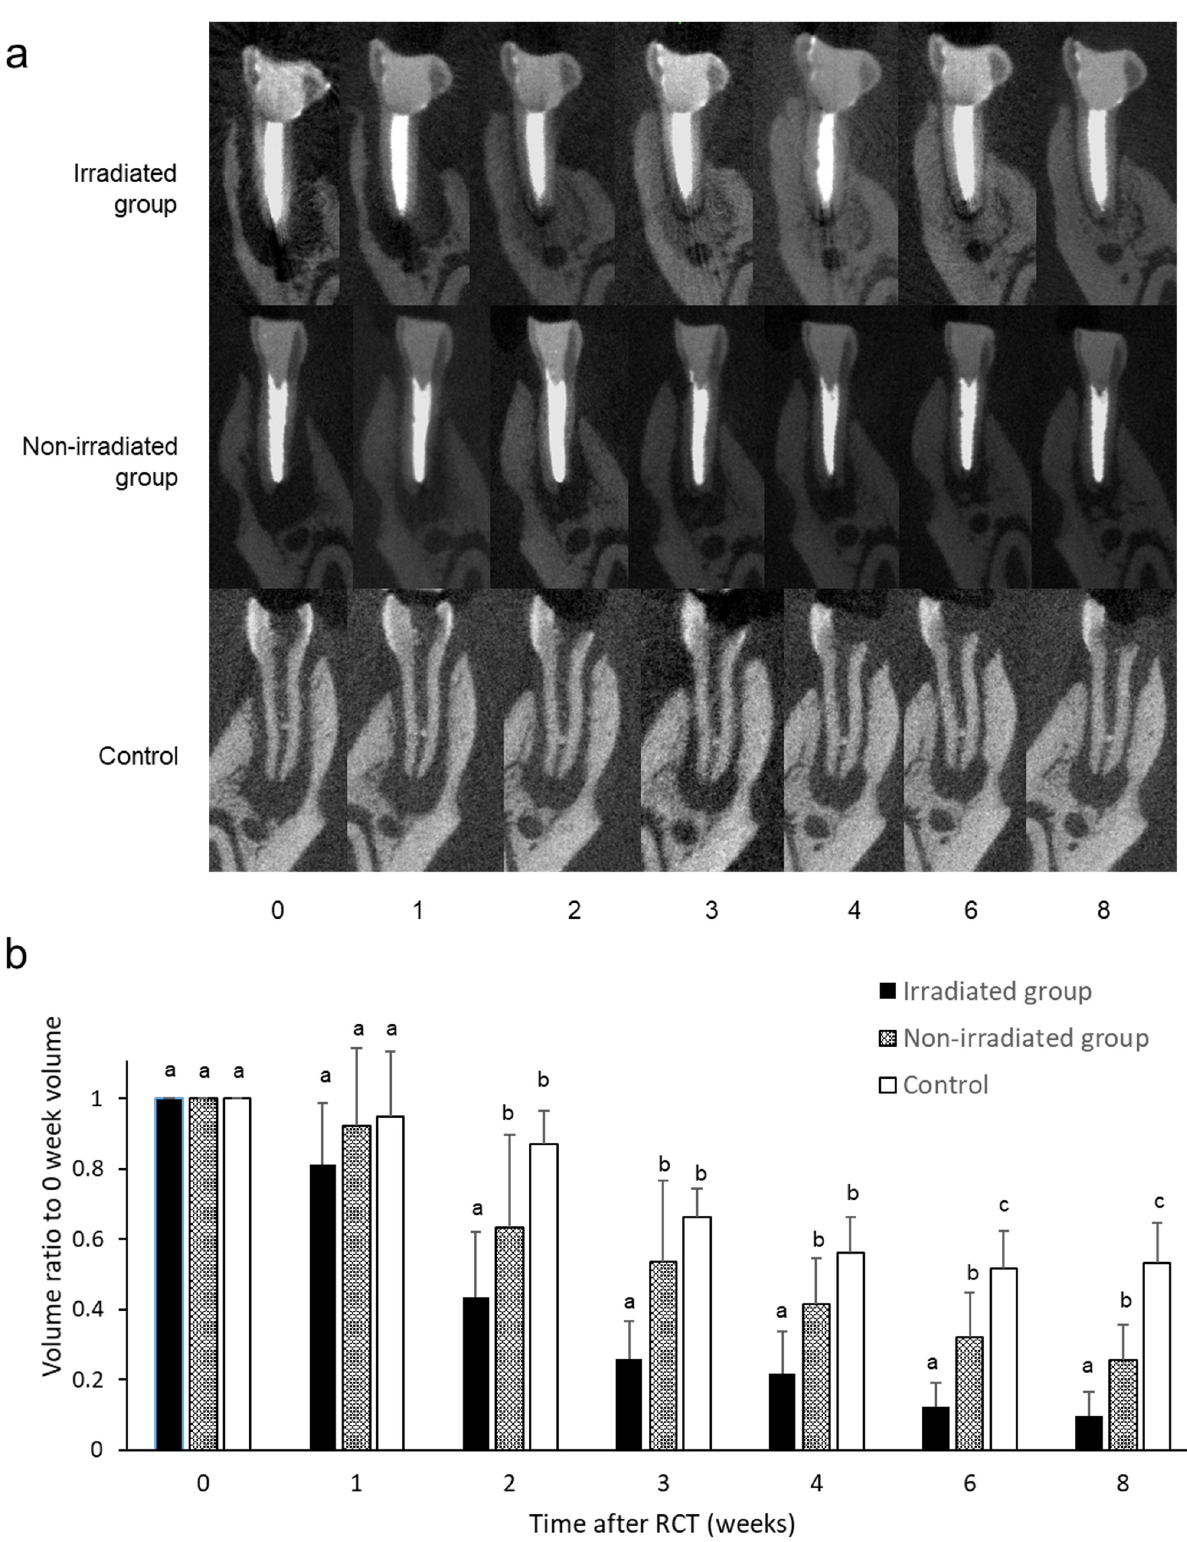
Fig 2. Three-dimensional measurement of periapical lesion volume. a: Representative micro-CT images of mesial root of mandibular first molar at each timepoint. b: The volume of the periapical lesion of the mesial root was measured at each timepoint (n = 6 each). The graph shows the mean and